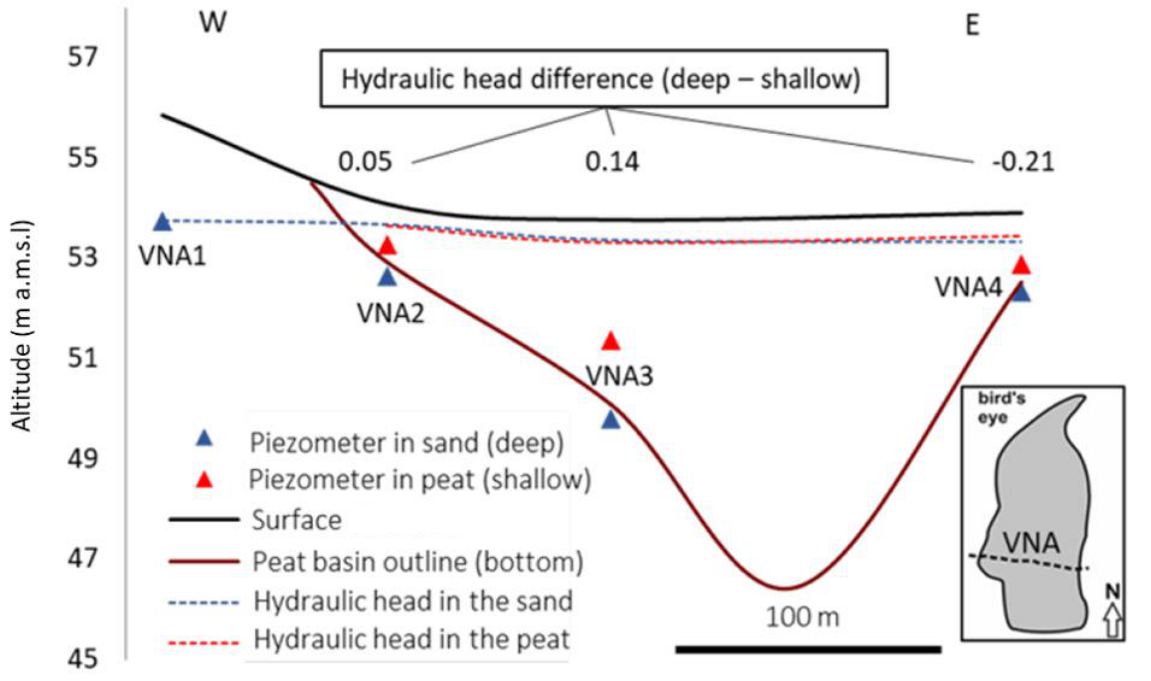
Figure 5. Hydraulic heads in the organic layer (blue dashed line) and the mineral layer (red dashed line) along Transect A, west to east direction, in